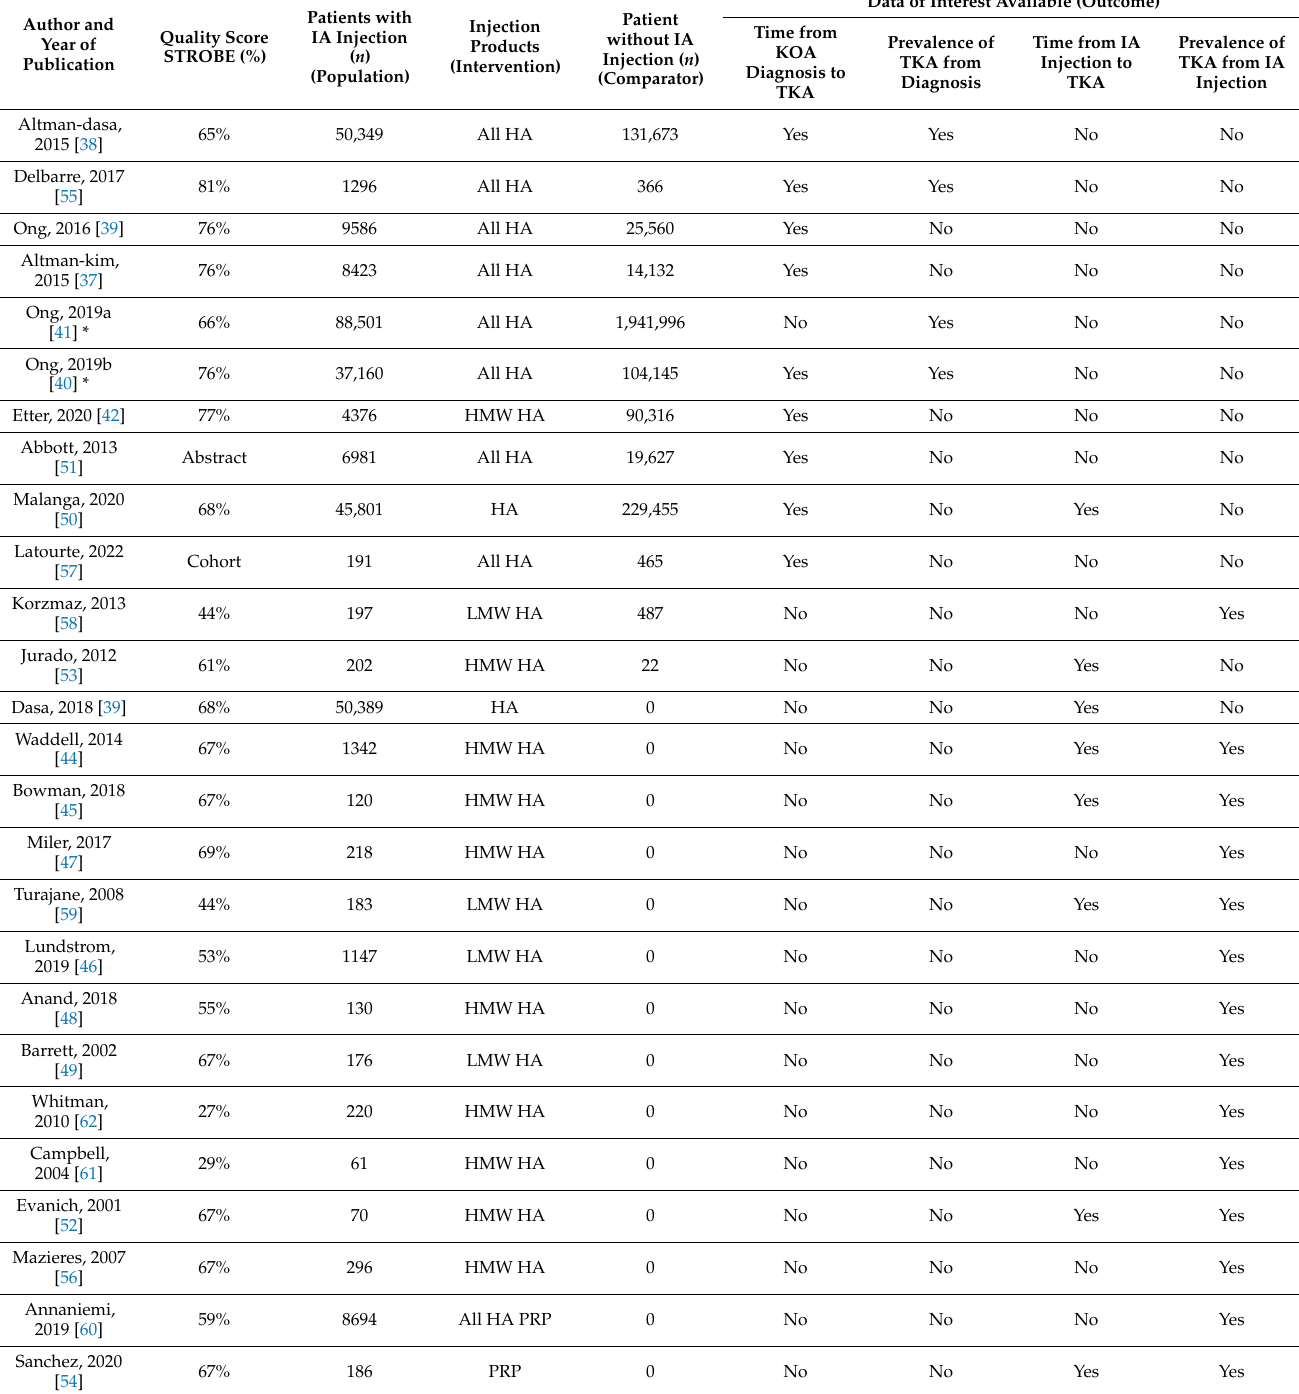
Table 1. Characteristics of included